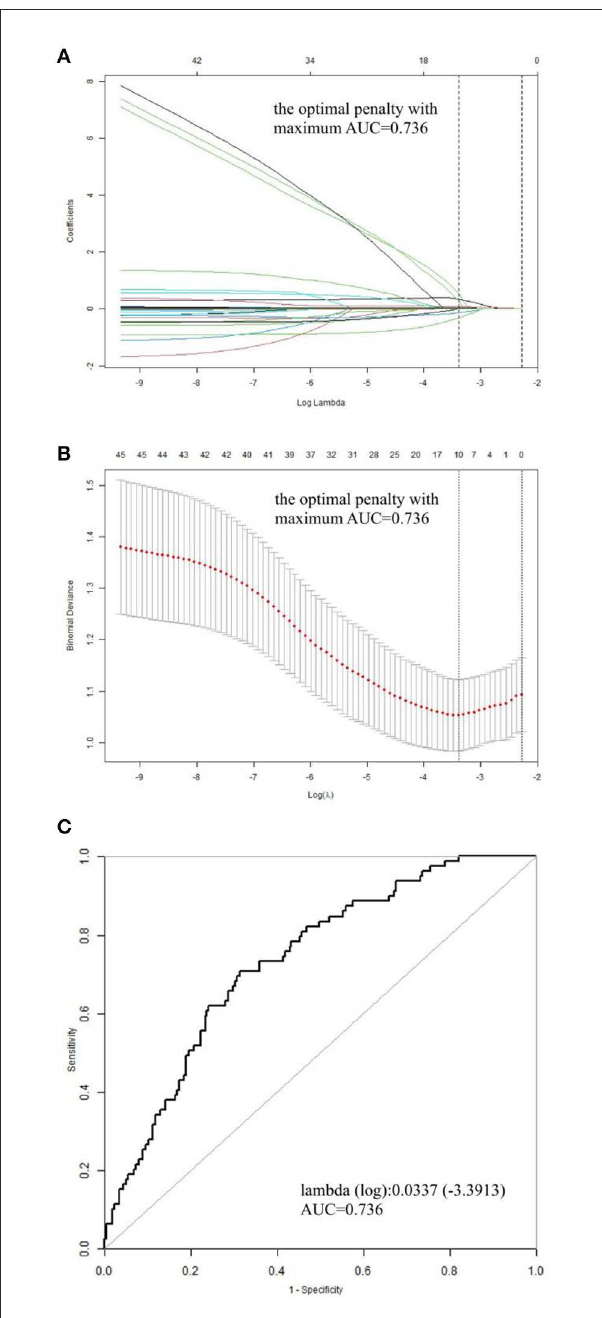
FIGURE1 Profile charts for the LASSO model. (A) The factors and their regression coefficients were chosen for the model based on the optimal k for the LASSO model, and the coefficient profile graphs demonstrate how the size of the preoperative variables’ coefficients keeps shrinking with the growing quantity of the k penalty. (B) Plotting penalties for the LASSO model. The standard error is displayed as colored error bars. (C) The ideal κ penalty for the LASSO model has an AUC maximum of 0.736. AUC, area under the receiver operating characteristic curve; LASSO, least absolute shrinkage and selection operator.